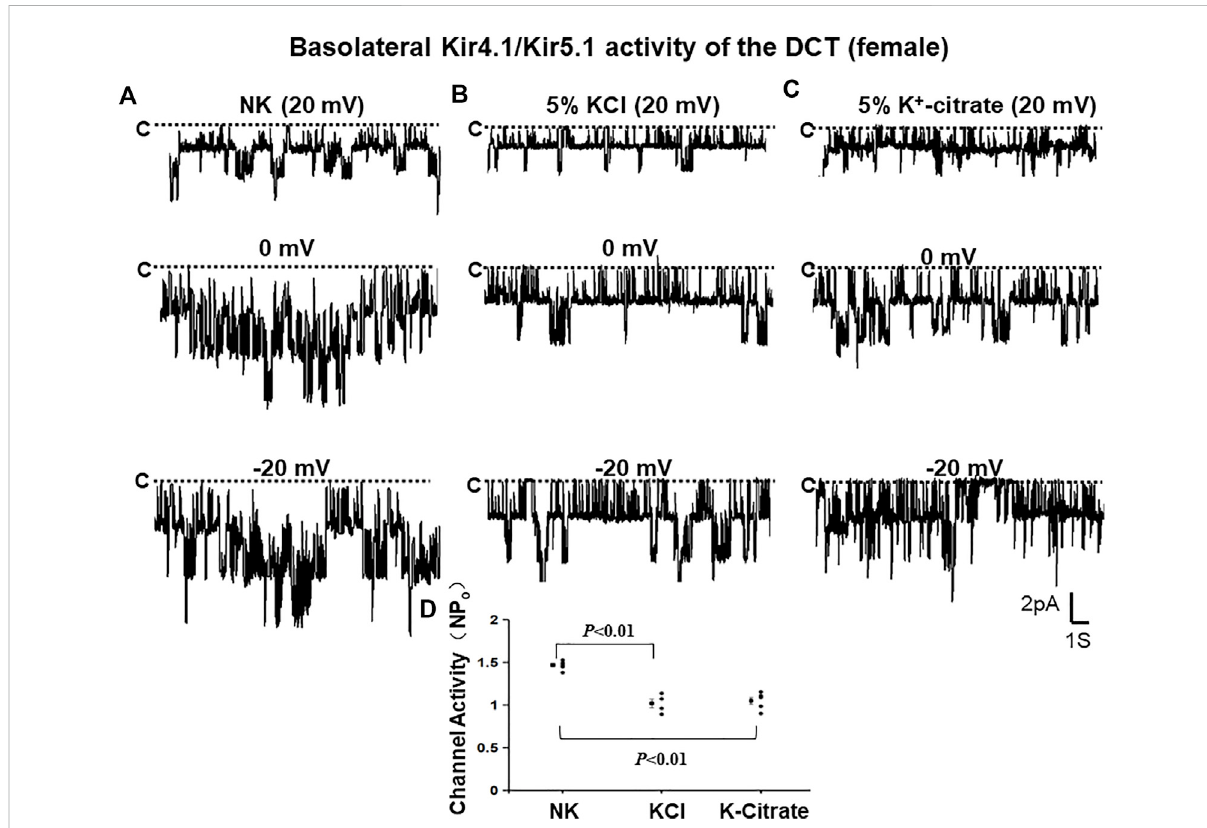
FIGURE 5 HK similarly inhibits Kir4.1/Kir5.1 of the DCT in female mice regardless Cl − content. A set of single-channel recordings shows the basolateral 40 pS K + channel activity in the DCT of female mice on NK (normal K + ,1% K) (A) , 5% K-Cl (B) , and 5% K-citrate diet (C) for 7 days, respectively. (D) A scatterplotsummarizingeachdatapointandmeanvalueofNP o measuredat0 mV.Thechannelclosedlevelisindicatedby “ C ” andadottedline.The holding potential for the patch-clamp is indicated on the top of each trace and it is 20 mV, 0 mV, and -20 mV, respectively. The bath solution contains 140 mM NaCl and 5 mM KCl and the pipette solution contains 140 mM